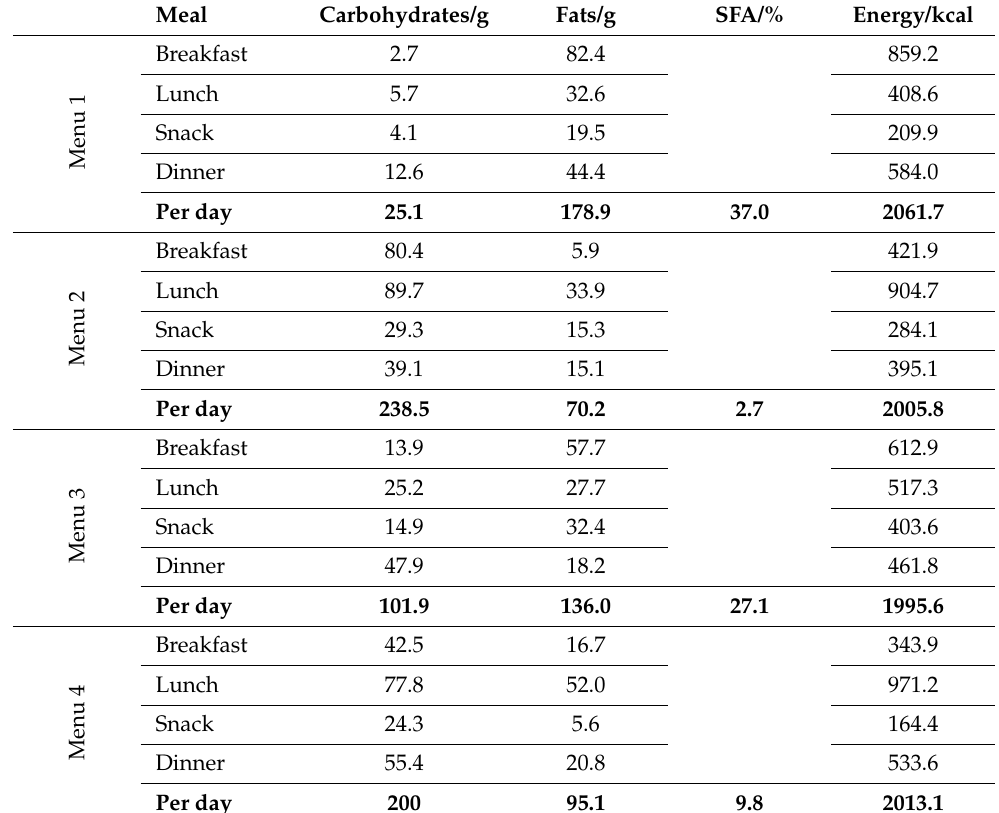
Table 5. Energy and macronutrient content (carbohydrates and fats) per meals according to meal plans with daily proportion of saturated fatty acids